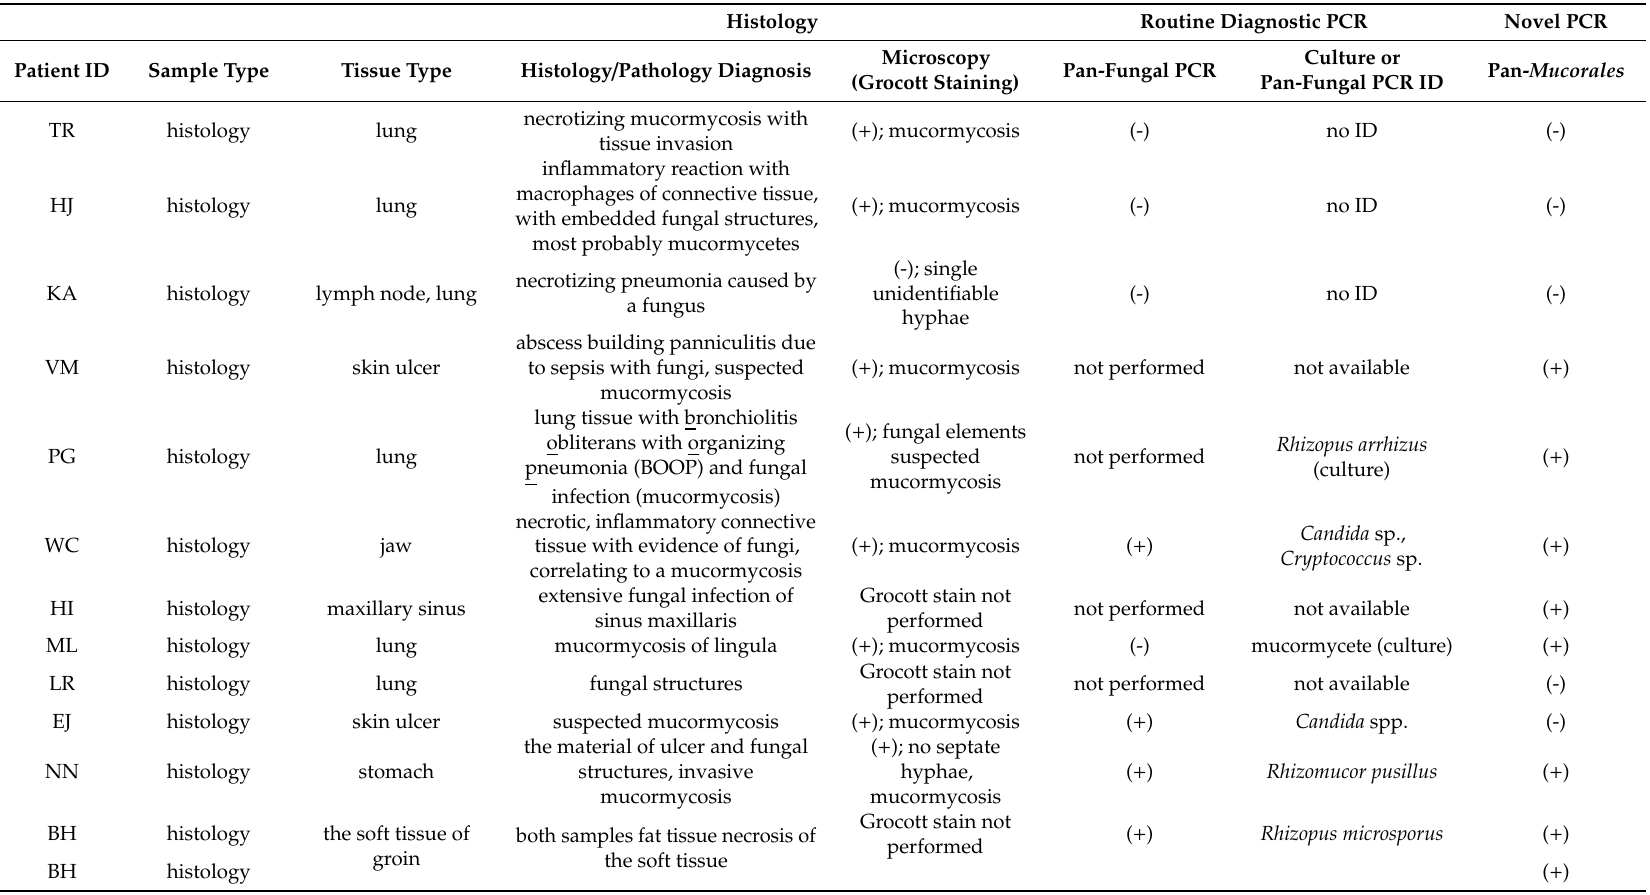
Table 1. Results from para ffi n-embedded tissue (FFPE) samples from patients with proven fungal infection and suspected